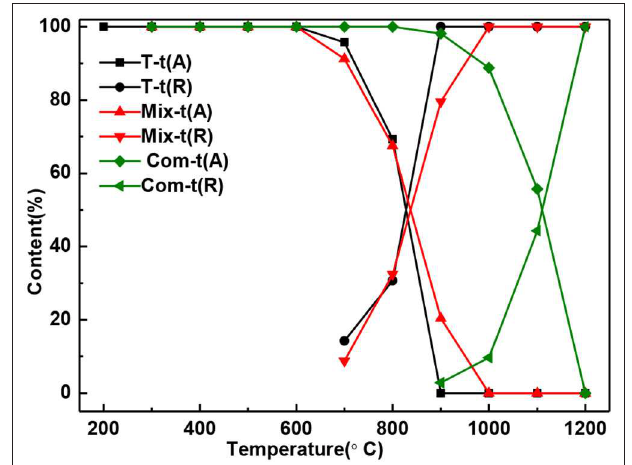
FIGURE 3 | The grain size change of anatase and rutile in T, Mix, and Com calcinated at the different temperatures.